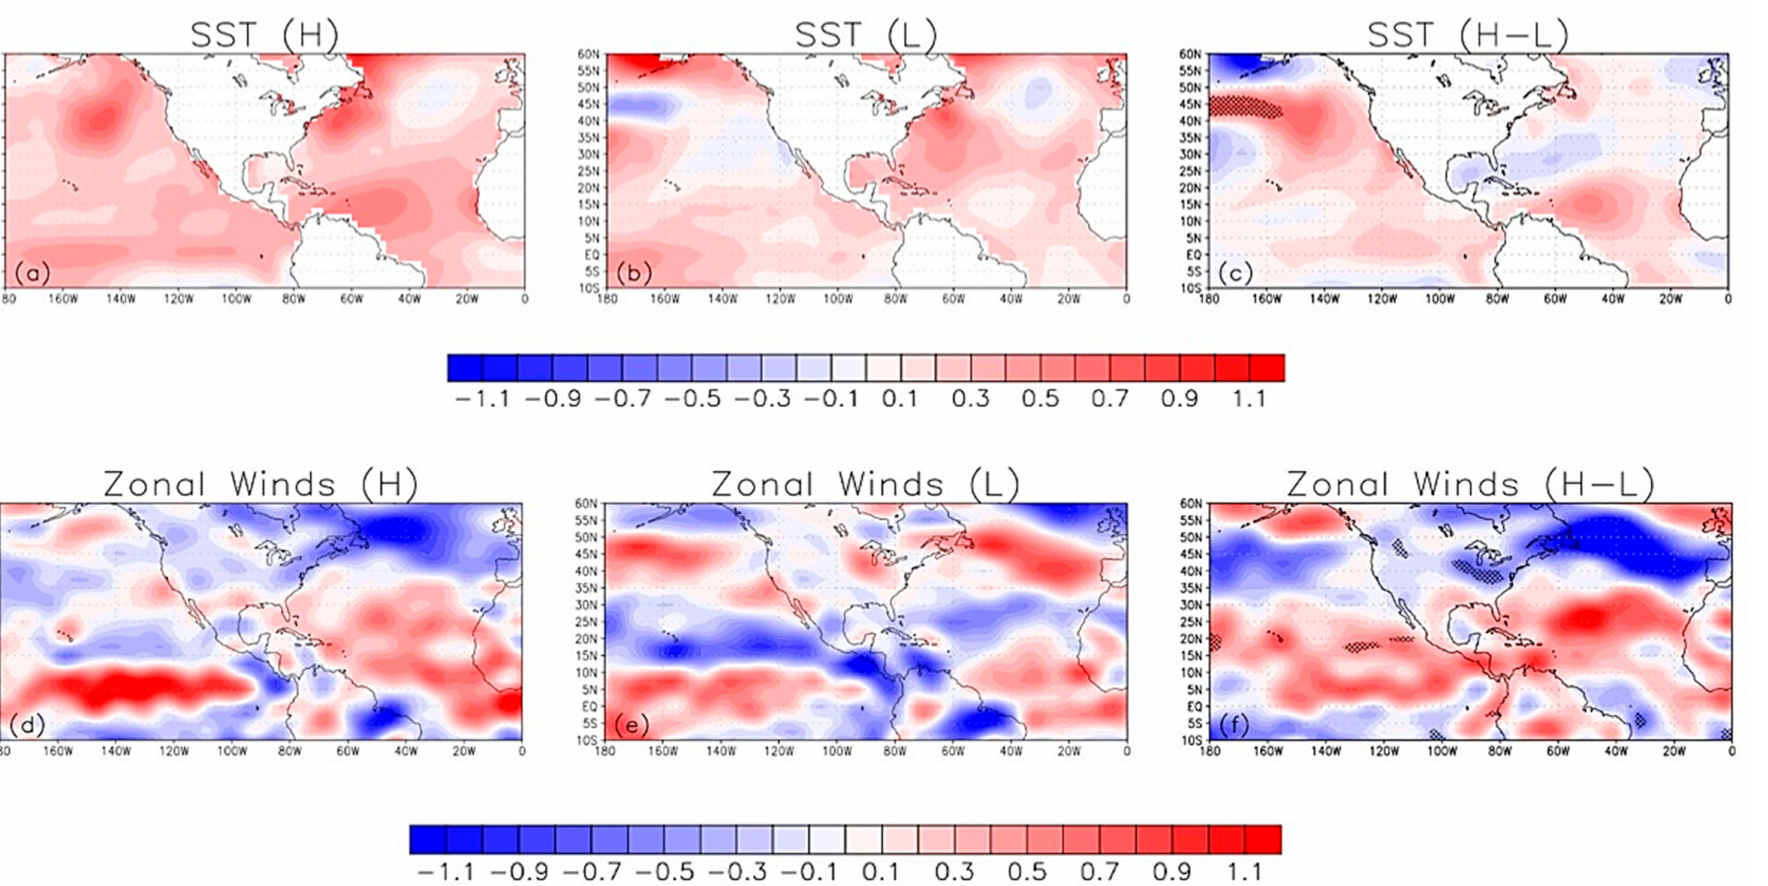
Figure 9. Composites of SSTA (K) and zonal wind anomalies (ms − 1 ) over the Pacific and Atlantic for high and low years of Jamaica fire frequency anomalies. ( a – c ) SSTA high, low and high minus low composite. ( d – f ) 925 mb zonal wind anomalies high, low and high minus low composite. Stippled areas show regions where composite differences are statistically significant at 95% confidence